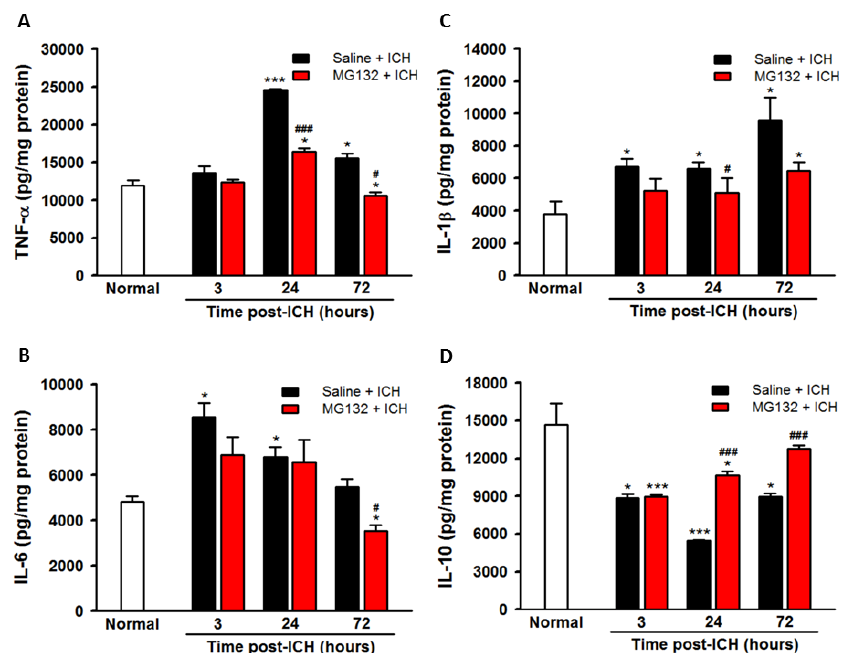
Figure 9. Expression levels of cytokines measured in the ipsilateral striatal tissues. The tumor necrosis factor- α (TNF- α ) ( A ), interleukin (IL)-6 ( B ), IL-1 β ( C ), and IL-10 ( D ) in normal, 3 h, 24 h, and 72 h post-ICH. Value are indicated by means ± SEM; n = 8 each group, * p < 0.05; *** p < 0.001; compared to normal group; # p < 0.05; ### p < 0.001; compared to Saline + ICH group, respectively.